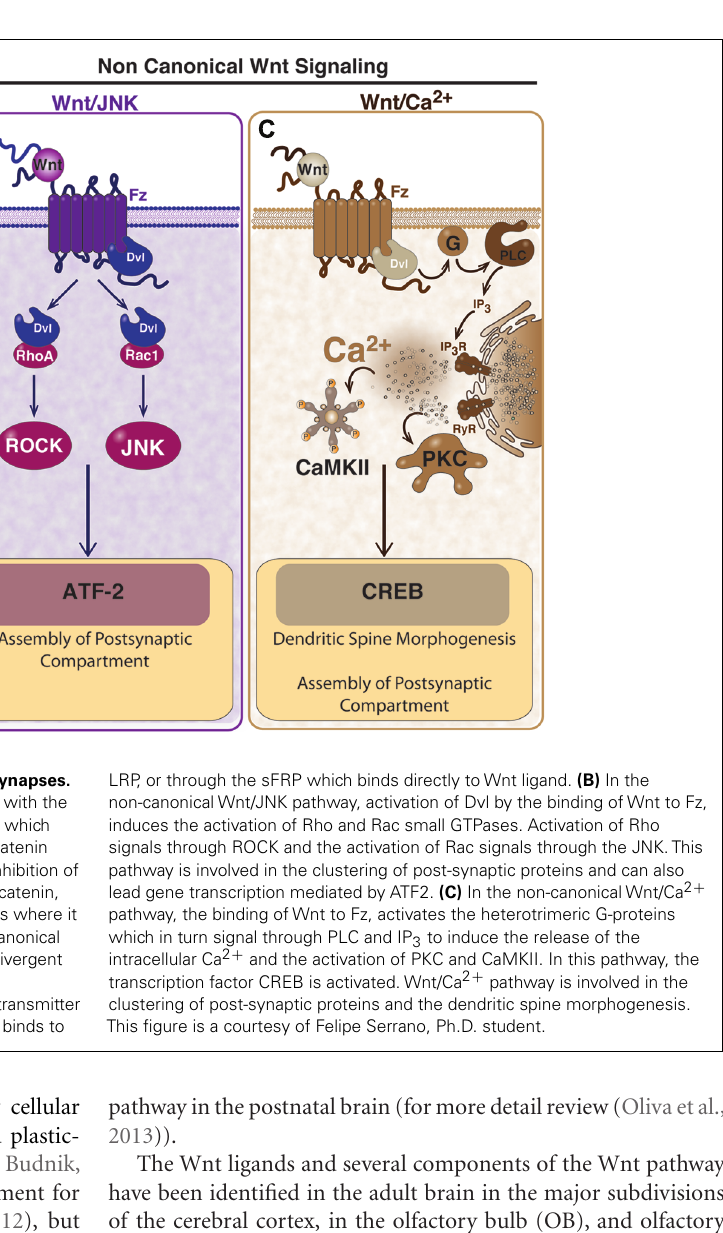
LRP, or through the sFRP which binds directly toWnt ligand. (B) In the non-canonicalWnt/JNK pathway, activation of Dvl by the binding ofWnt to Fz, induces the activation of Rho and Rac small GTPases. Activation of Rho signals through ROCK and the activation of Rac signals through the JNK.This pathway is involved in the clustering of post-synaptic proteins and can also lead gene transcription mediated by ATF2. (C) In the non-canonicalWnt/Ca 2 + pathway, the binding ofWnt to Fz, activates the heterotrimeric G-proteins which in turn signal through PLC and IP 3 to induce the release of the intracellular Ca 2 + and the activation of PKC and CaMKII. In this pathway, the transcription factor CREB is activated.Wnt/Ca 2 + pathway is involved in the clustering of post-synaptic proteins and the dendritic spine morphogenesis. This figure is a courtesy of Felipe Serrano, Ph.D.